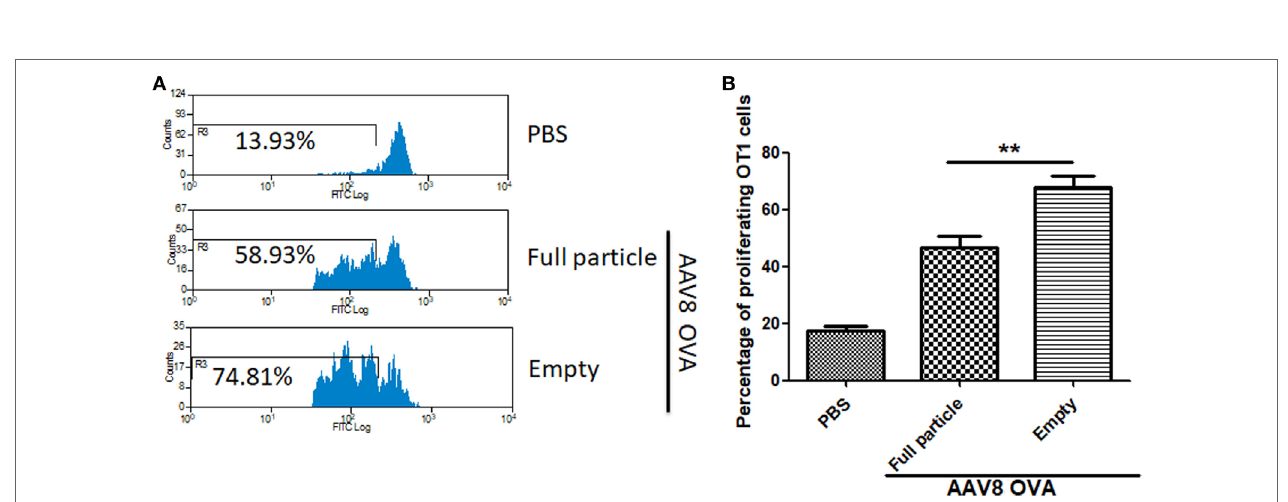
FIGURE 5 | The capsid antigen presentation from AAV8OVA empty virions in mice. 2 × 10 11 particles of AAV8OVA viruses (empty or full) were injected into C57BL/6 mice retro-orbital vein, and at day 3 post AAV8OVA injection, 5 × 10 6 CFSE-labeled OT-1T cells were transferred. Ten days posttransfer, proliferation of OT-1 cells was measured by flow cytometry. (A) Representative flow cytometric histograms. (B) Average T cell proliferation and SD for four mice. * p < 0.05 when compared to mice treated with AAV8OVA full